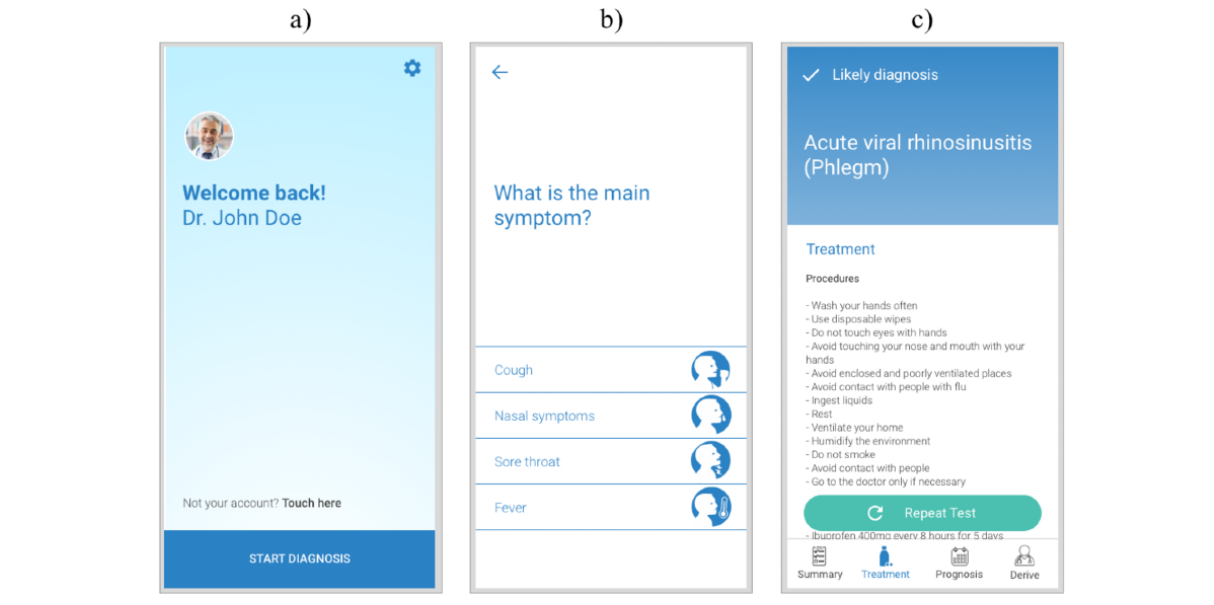
Figure 3. Light theme interface redesign examples after evaluation. (a) Homepage; (b) first question page; and (c) likely diagnosis page. Note: English versions made specifically for the purposes of this